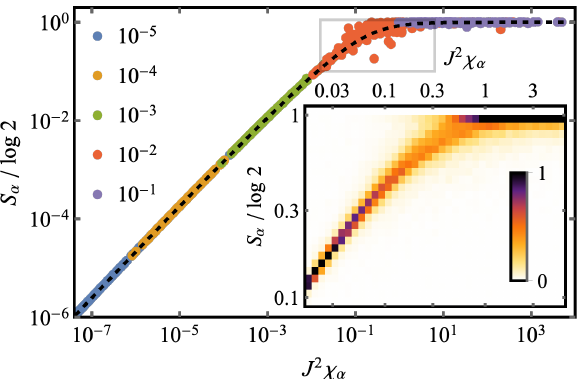
Figure 5: Values of ( S α , χ α ) : The entanglement entropy of S α of a eigenstate of the Spin-ETH model as a function of the fidelity susceptibility of the corresponding eigen- states of H ( J = 0). For each value of the coupling J (coloured points, J values in 0 legend), N = 200 points corresponding to randomly selected mid-spectrum eigen- states are shown. Inset a histogram of data aggregated across many diagonalisations showing the distribution within the grey boxed region of the main plot. Each col- umn of cells in the inset is normalised to sum to unity. Parameters L = 12, other parameters as in Fig. 4.